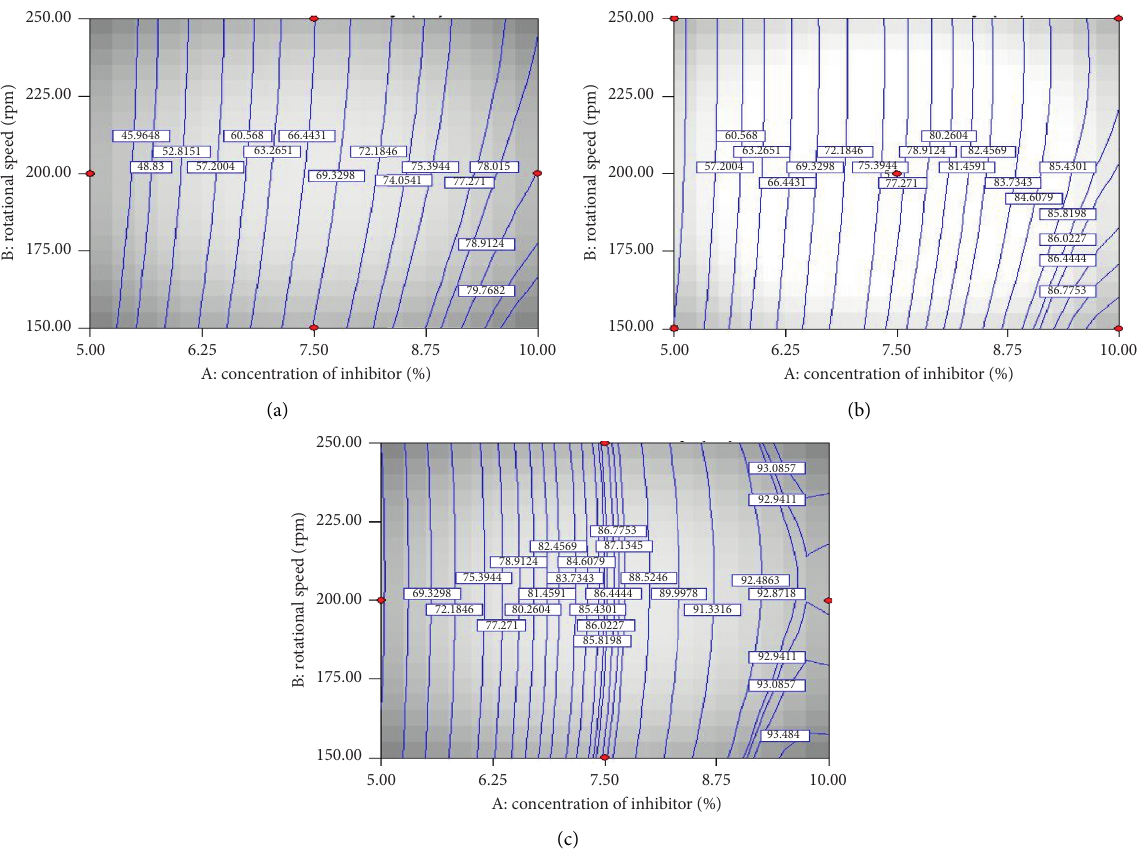
Figure 14: Contour plot of the inhibition efficiency as a purpose of inhibitor load and rotational speed at the temperatures (a) 75 ° C, (b) 50 ° C, and (c) 25 °